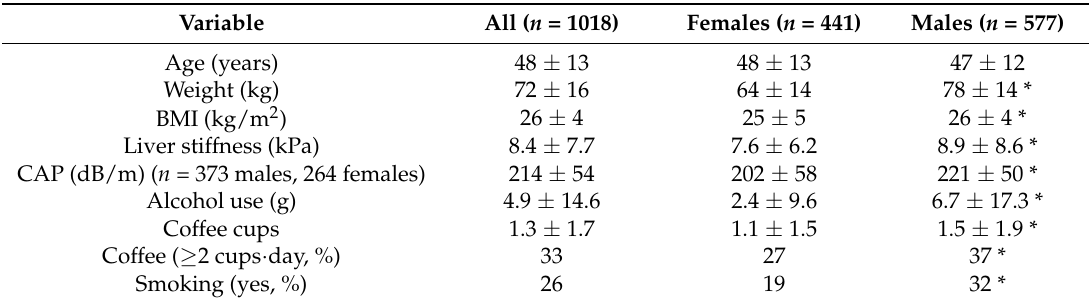
Table 1. Patient characteristics overall and by